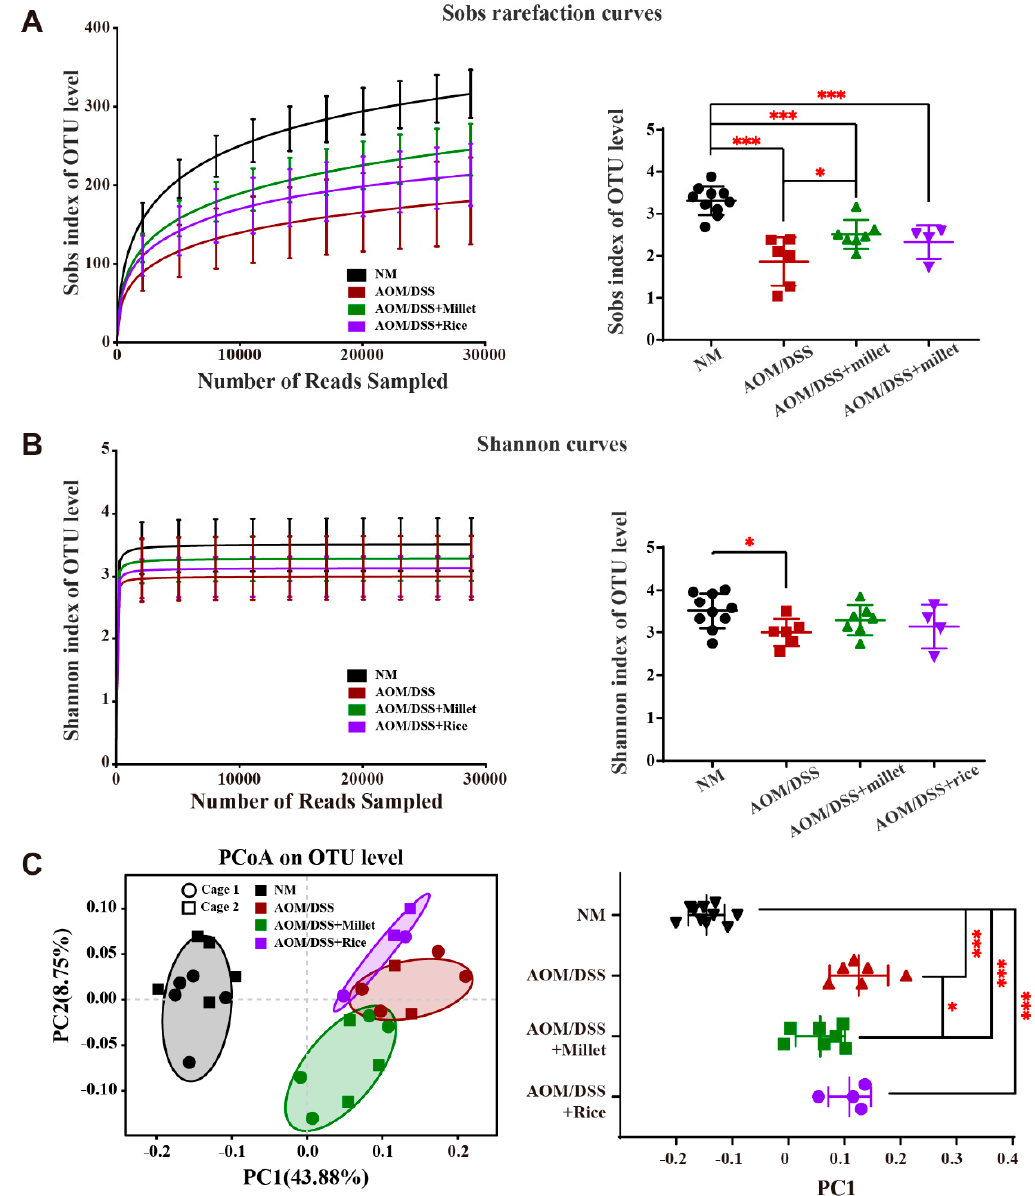
Figure 7. Effects of millet and rice on gut microbial diversity and composition. ( A ) Sobs index and rarefaction curves. ( B ) Shannon index and rarefaction curves. ( C ) Unweighted Unifrac PCoA analysis of gut microbiota metagenomes at the OTU level. * p < 0.05, *** p < 0.001 by Kruskal–Wallis with Dunn’s test. n = 10, 6, 7, and 4 for the NM, AOM/DSS, AOM/DSS + millet, and AOM/DSS + rice groups, respectively.